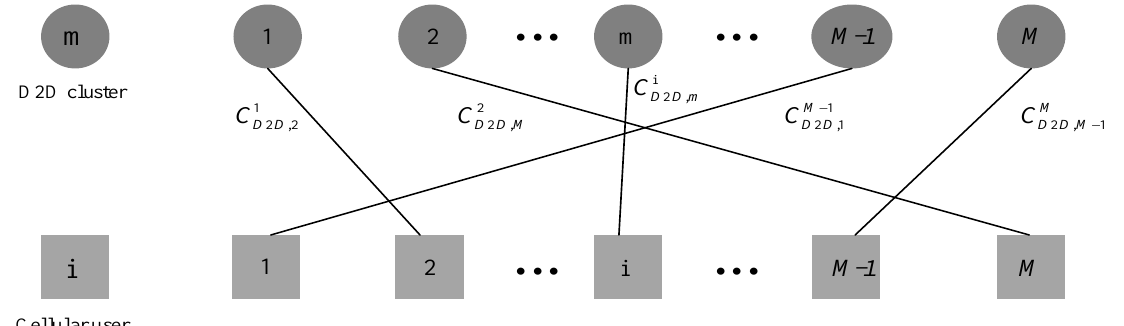
Figure 2. Weighted bipartite graph for optimal matching problem of D2D clusters and cellular users’ channels. Algorithm 1. Optimal joint power control and channel allocation